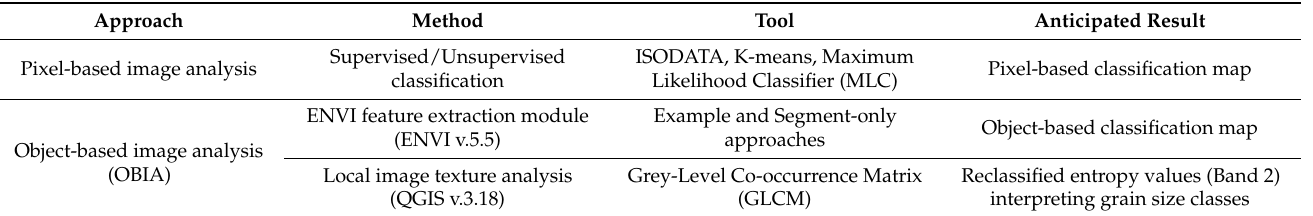
Table 2. Tested methods and approaches for dominant grain size classification applied to the lower part of Xerias